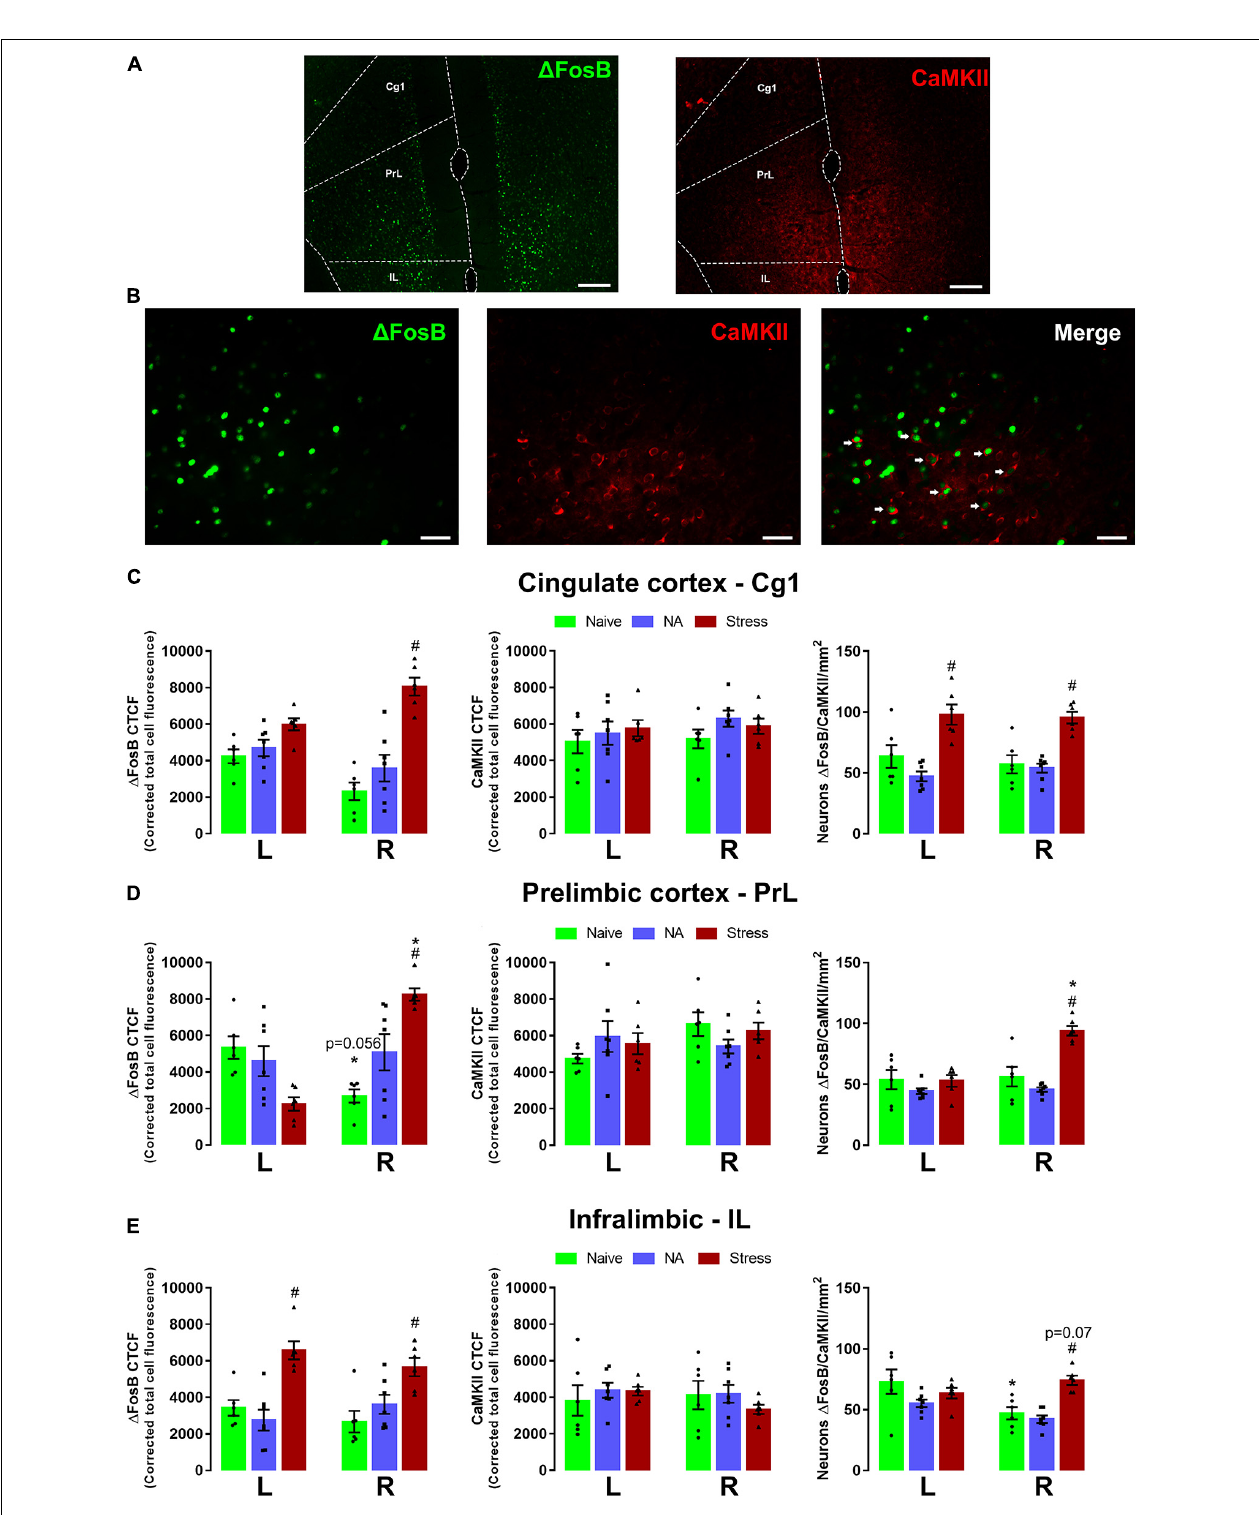
FIGURE 3 | Representative × 10 (scale bar = 200 µ m) (A) and × 40 (scale bar = 20 µ m) (B) images showing (cid:49) FosB, CaMKII immunoreactivity, and double-labeling merge for (cid:49) FosB and CaMKII in the mPFC. Corrected total cell fluorescence (CTCF) for (cid:49) FosB and, CaMKII, and (cid:49) FosB + CaMKII-positive neurons in the Cg1 (C) , PrL (D), and IL (E) . Sample sizes: Naive ( n = 6), NA ( n = 7), and SDS ( n = 6). Bars with scatter dot plot represent mean ( ± SEM). * p < 0.05 compared with the same group on the opposite hemisphere. # p < 0.05 compared with the naive and NA group. L, left hemisphere; R, right hemisphere; NA, non-aggressive; SDS, social defeat stress; mPFC, medial prefrontal cortex; Cg1, cingulate; PrL, prelimbic; IL, intralimbic.